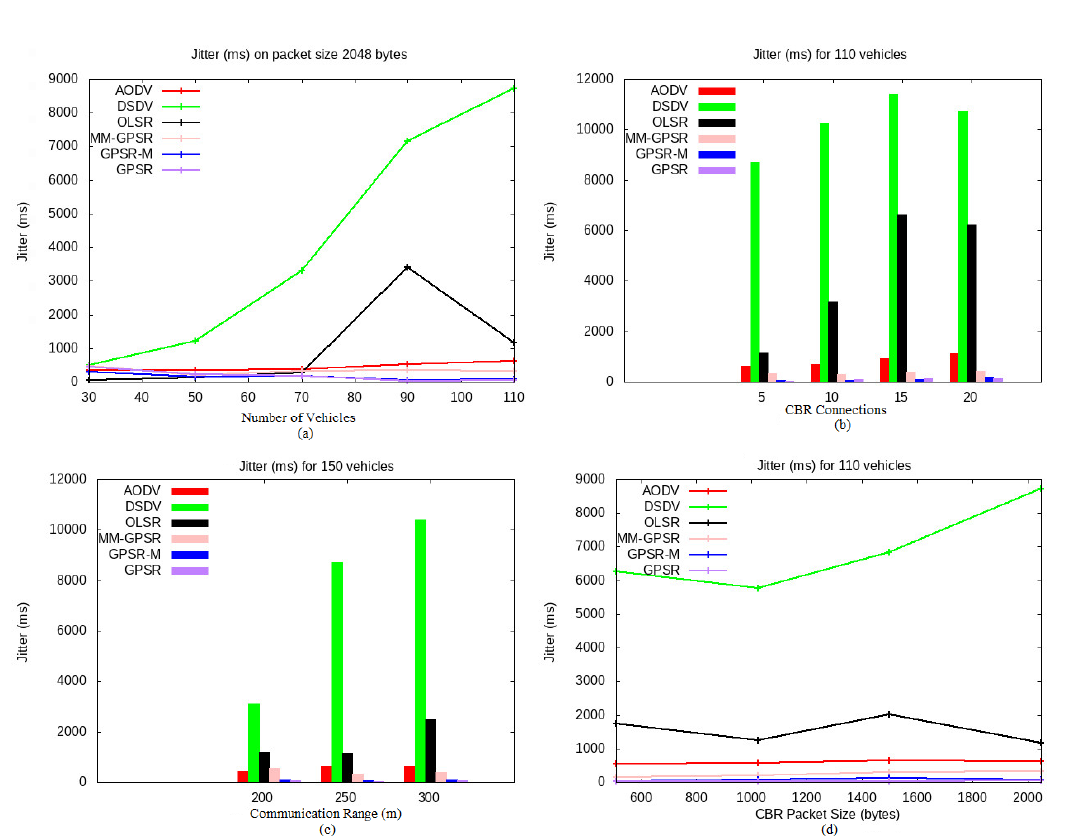
Figure 8. Jitter results on various network